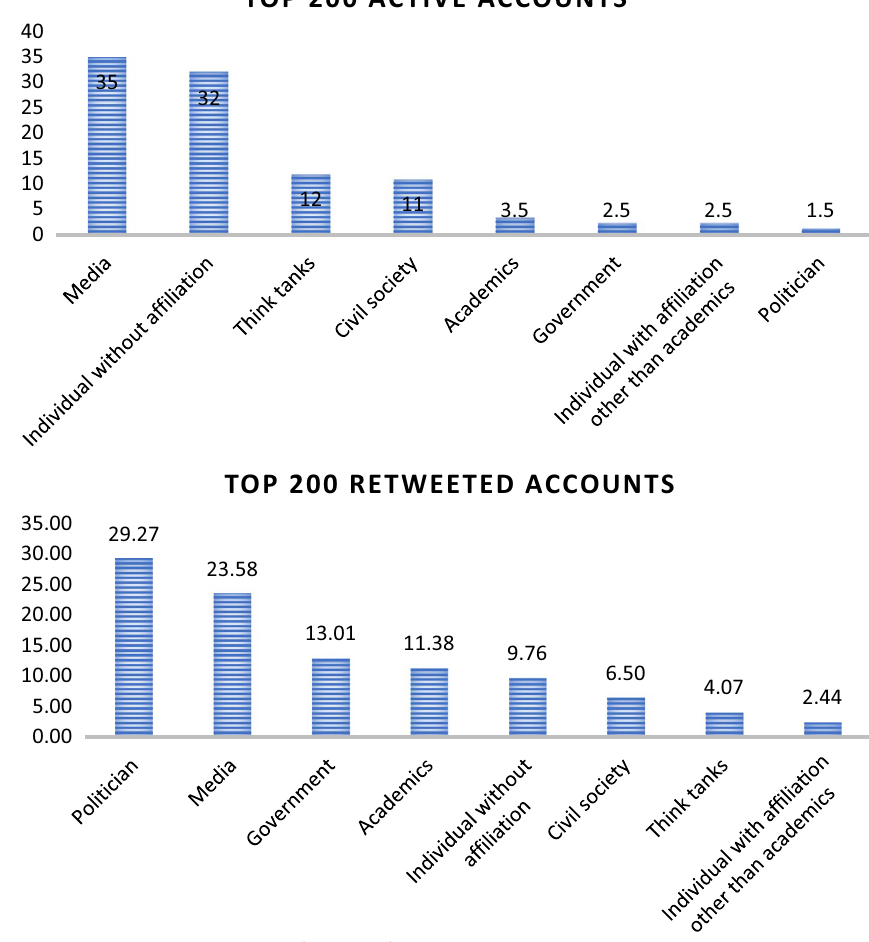
Fig. 13 Top 200 active accounts and retweeted